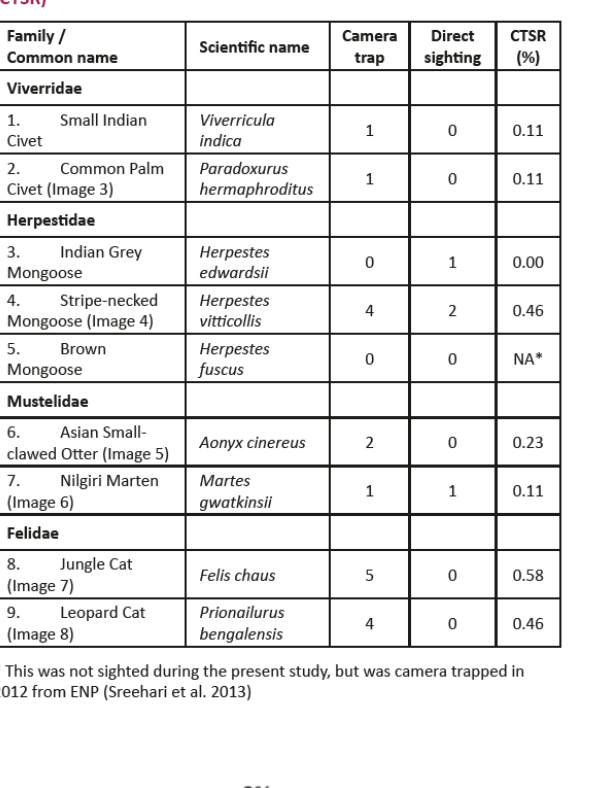
Ffigure 3. Relafive abundance off small carnfivores ffrom pfieces off findfirect evfidence fin the montane fforests off Eravfikulam Nafional Park